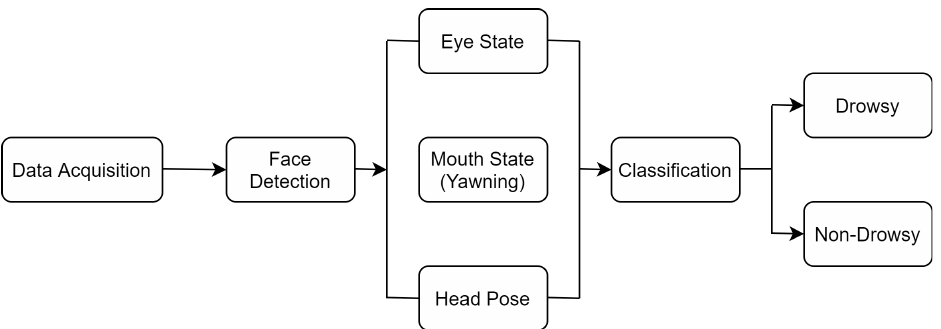
Figure 3. Detection of driver drowsiness using behavioral measures .